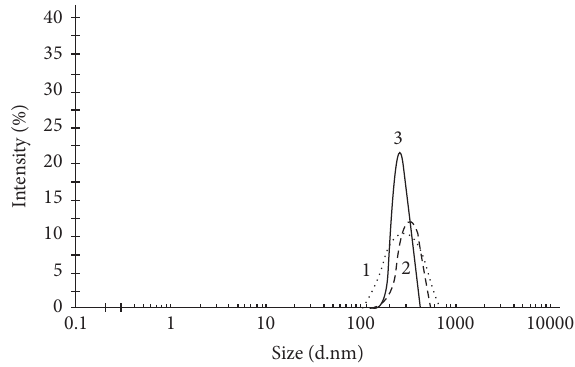
Figure 1: Particle size distribution of W/O/W emulsions of SMSG (1), LSSG (2), and mix (3). SMSG, Salvia macrosiphon Seed Gum; LSSG, Lepidium sativum Linn. Seed Gum; and CSL, complex of SMSG and LSSG